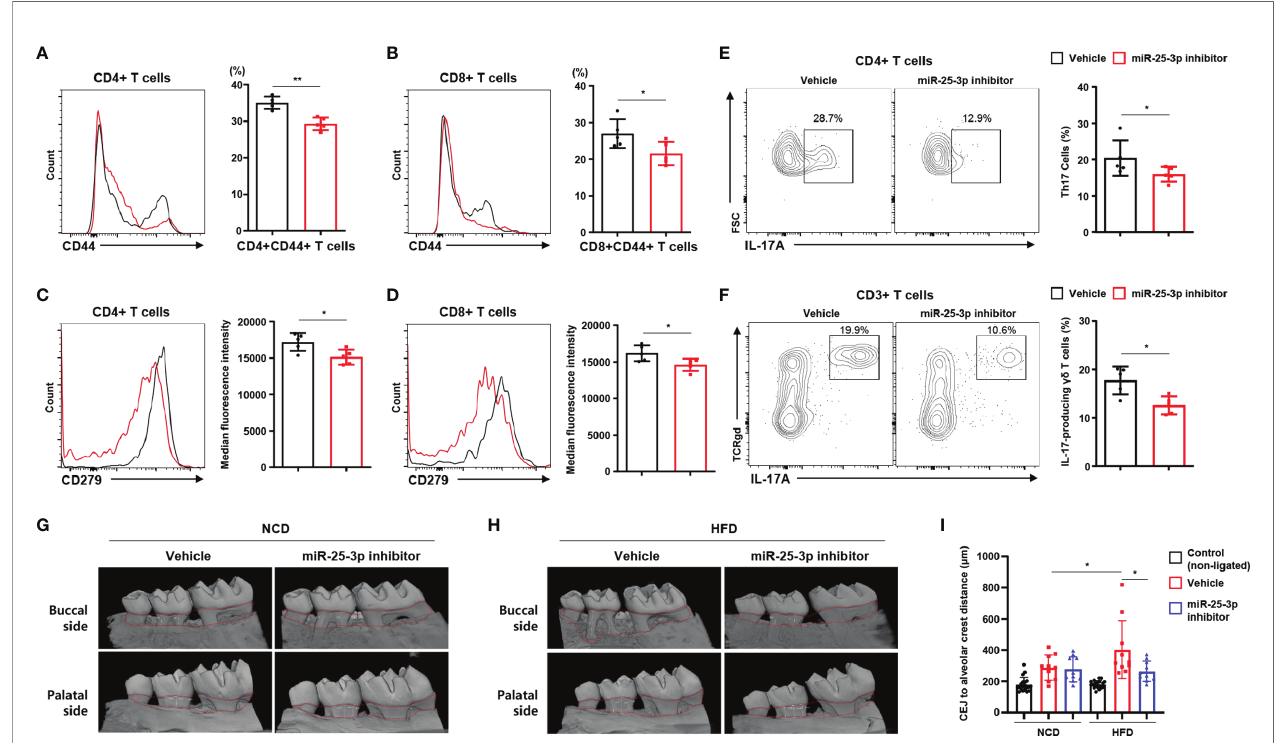
FIGURE 4 | Treatment with miR-25-3p inhibitor decreases the populations of effector T cells and IL-17-producing cells in in fl amed gingiva of obese male mice with periodontitis. (A, B) Size of the CD44 + population in in fl amed gingiva-in fi ltrating CD4 + and CD8 + T cells from periodontitis-induced obese male mice treated with either miR-25-3p inhibitor (n = 5) or vehicle (n = 5). (C, D) Median fl uorescence intensity of CD279 was measured in in fl amed gingiva-in fi ltrating CD4 + and CD8 + T cells of periodontitis-induced obese mice treated with either miR-25-3p inhibitor or vehicle. (E) Representative fl ow cytometry plots and percentages in in fl amed gingiva-in fi ltrating IL-17A-producing cells of the population of CD4 + T cells in periodontitis-induced obese mice treated with either miR-25-3p inhibitor or vehicle. (F) Representative fl ow cytometry plots and percentages in in fl amed gingiva-in fi ltrating IL-17A-producing cells of the population of gd T cells from periodontitis- induced obese mice treated with either miR-25-3p inhibitor or vehicle. (G, H) Synchrotron radiation micro-computed tomography analysis of periodontitis-induced bone loss in mice fed either a NCD or HFD and treated with either miR-25-3p inhibitor or vehicle. The upper red-dotted line indicates the cemento-enamel junction; the lower red-dotted line indicates the alveolar bone crest (left panel). (I) The distances from cemento-enamel junctions to alveolar bone crests were measured around the second molars on transaxial and sagittal sections along the buccal, palatal, and interdental axes. Distances were statistically analyzed in mice fed either a NCD or a HFD and treated with either miR-25-3p inhibitor or vehicle. Data represent mean value of more than three independent experiments. Data are expressed as the mean ± SEM. *p < 0.05, **p < 0.01 (A – F) , two ‐ tailed t tests; (G – I) , one ‐ way